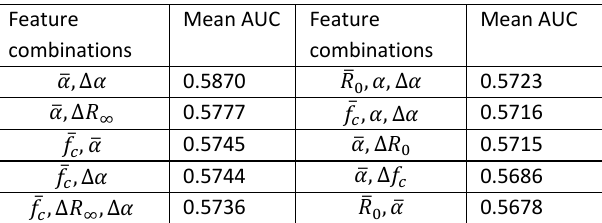
Table.5: Mean AUC values from 100 5-fold cross validation runs with linear logistic regression